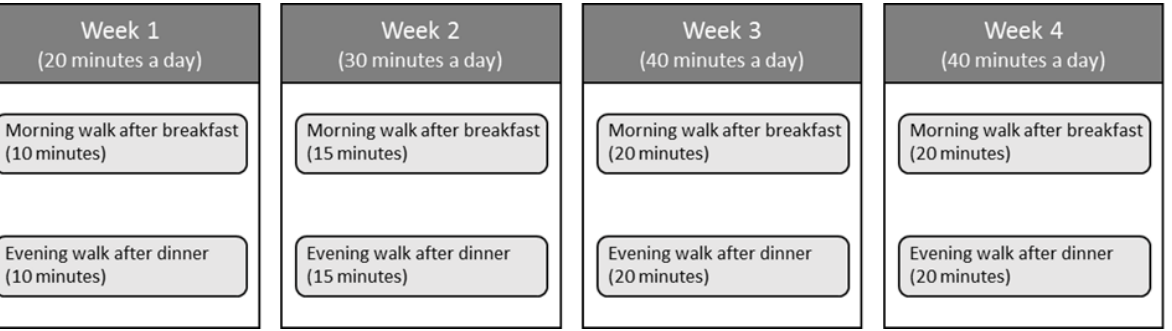
Figure 2. An example of a personalized rehabilitation plan for a